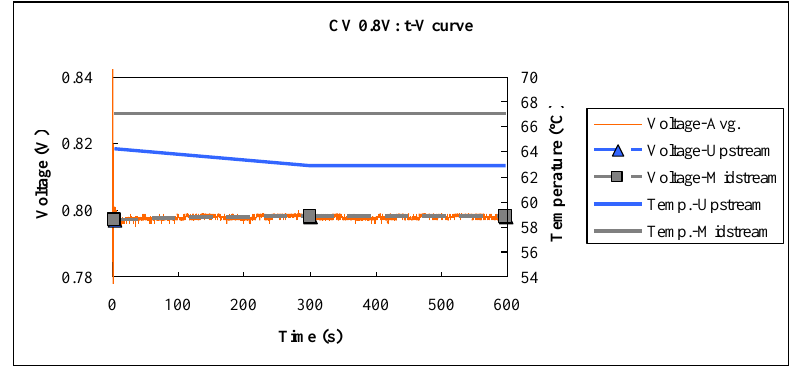
Figure 10. Voltage and temperature difference at constant voltage 0.6 V. CV 0.6V: t-V curve